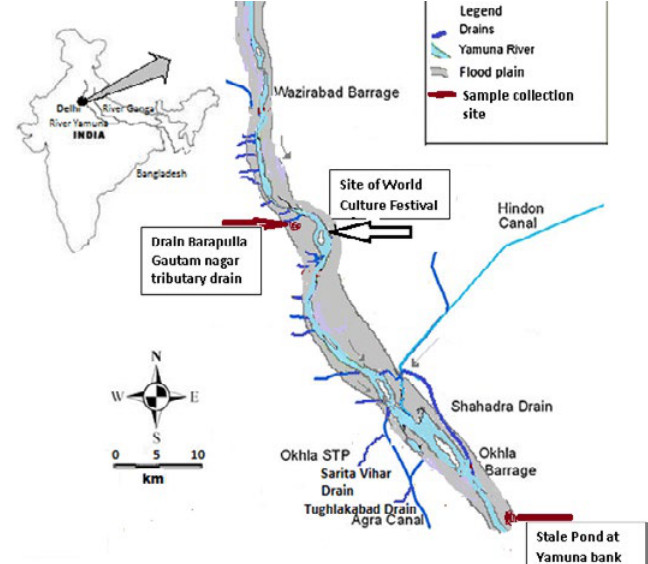
Fig. 1: Geographic locations of the study area at river bank, showing sites of event and water sample collection for eco-enzyme testing